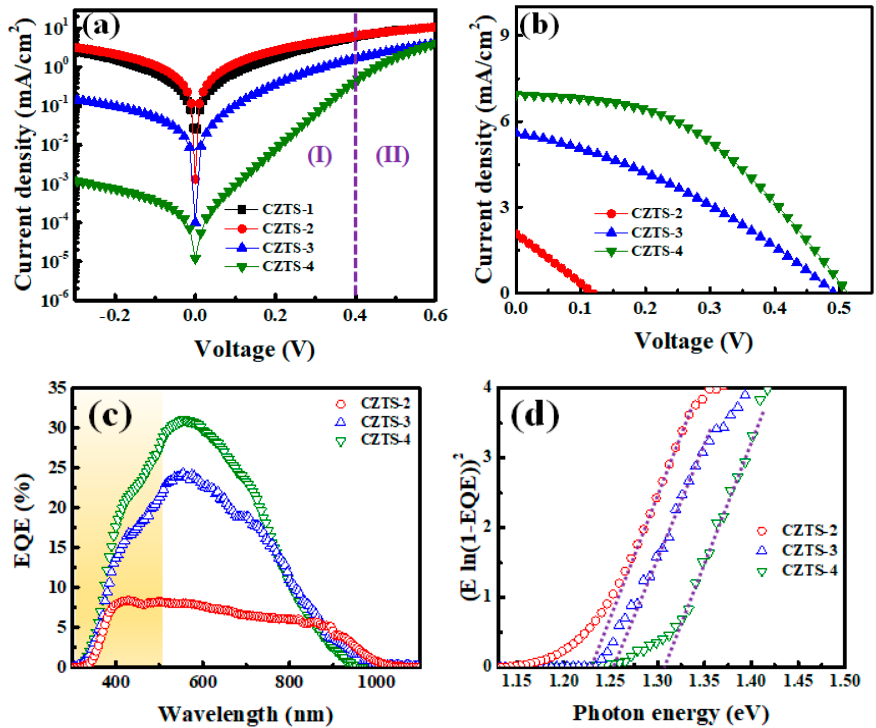
Figure 7. J–V measurements ( a ) in the dark and ( b ) under AM 1.5G light for CZTS − 1, CZTS − 2, CZTS − 3, and CZTS − 4. ( c ) EQE of CZTS − 2, CZTS − 3, and CZTS − 4 samples under AM1.5 illumina- tion; ( d ) band gap determination of the cell from the EQE